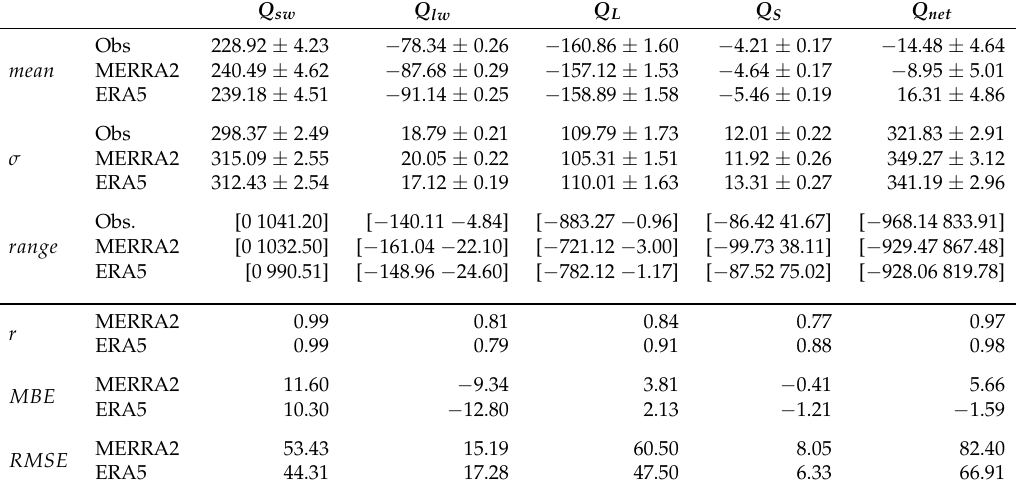
Table 6. Comparison between hourly-average surface air–sea fluxes from reanalysis products (NASA-MERRA2 and ECMWF-ERA5) and derived from in situ observations in the northern Red Sea (22.17 ◦ N; 38.5 ◦ E). The time series from both reanalyses and in situ observations span the period from October 2008 to December 2010. The following surface air–sea fluxes were analyzed; net shortwave radiation ( Q sw ), net longwave radiation ( Q lw ), latent heat ( Q L ), sensible heat ( Q S ), and net heat flux ( Q net ) ; air–sea flux units are W/m 2 . The upper part of the table expresses basic statistics for the individual datasets (sample mean, sample standard deviation, minimum and maximum). The lower part of the table shows the linear correlation coefficients, which are statistically significant at 95%, the mean bias errors ( MBE ) and the root-mean-square-error ( RMSE ) between the reanalyses and in situ data ( ∆ = reanalysis − in situ). ± indicates 95% confidence interval estimated using the bootstrap